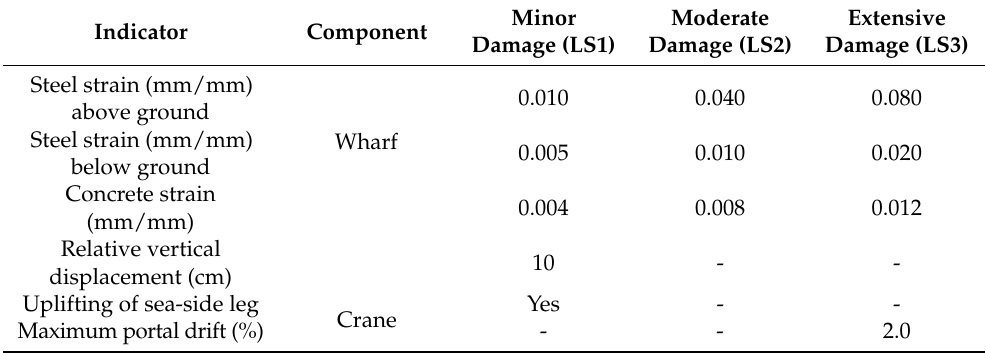
Table 2. Definition of damage states for the object port infrastructure components.